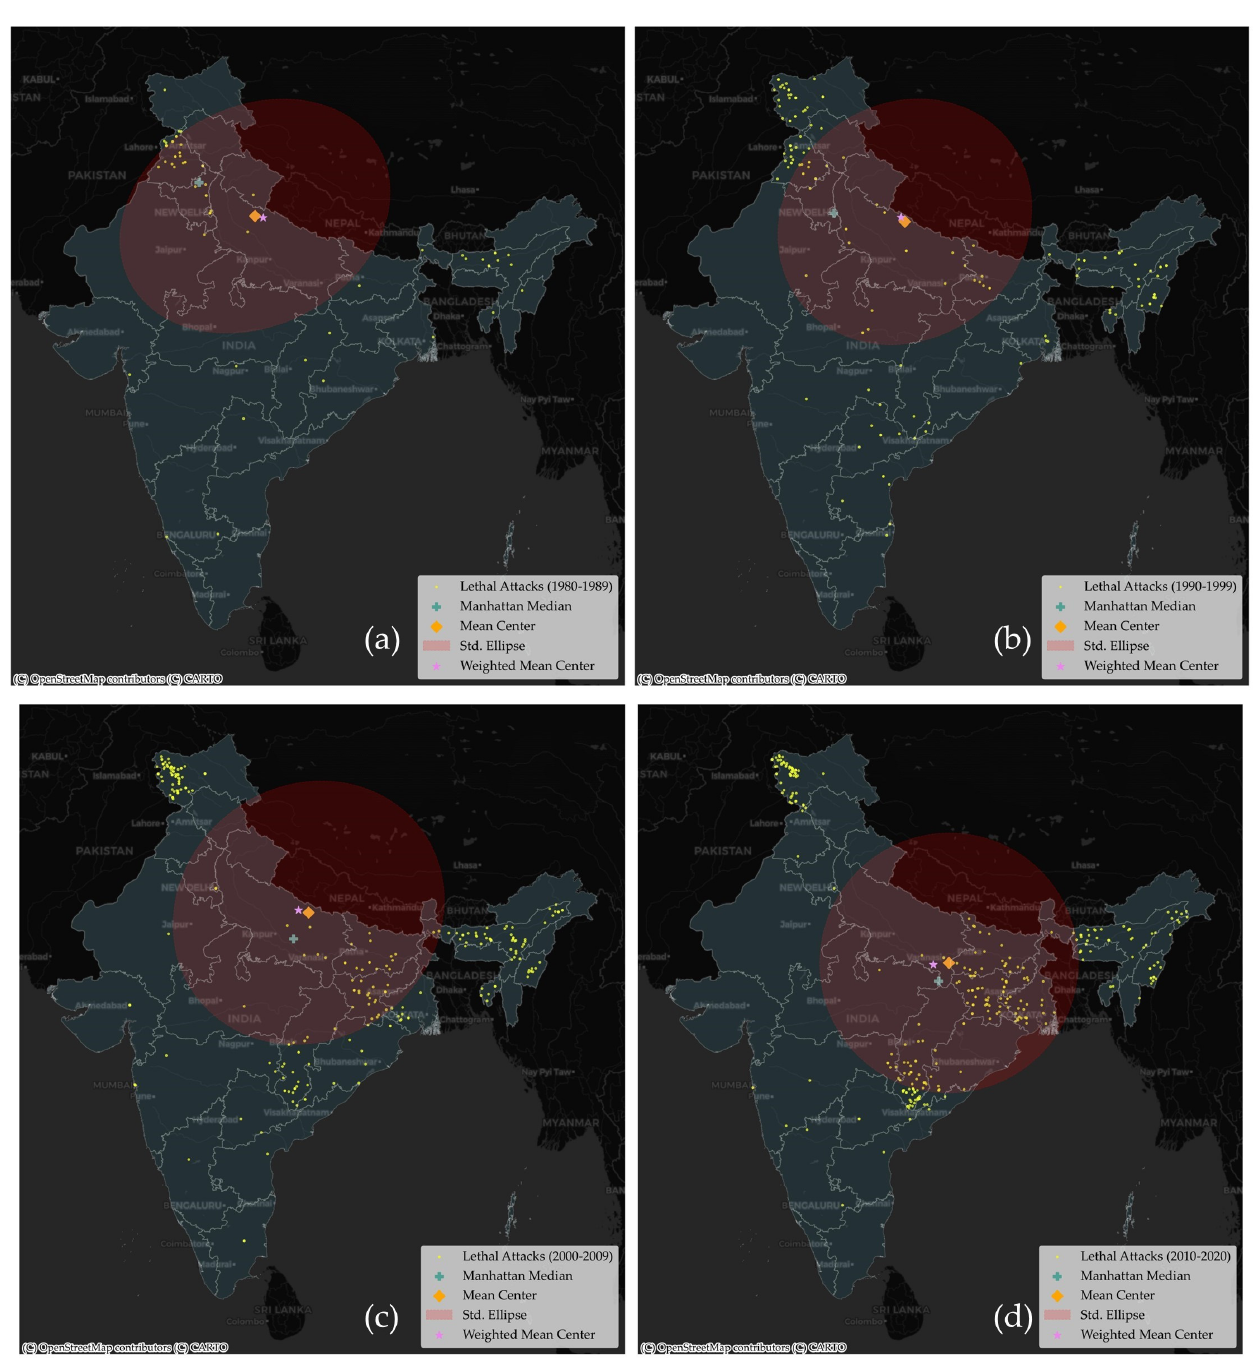
Figure 15. Spatiotemporal evolution of lethal a tt acks in India. ( a ) Lethal a tt acks in the decade 1980–1989. ( b ) Lethal a tt acks in the decade 1990–1999. ( c ) Lethal a tt acks in the decade 2000–2009. ( d ) Le-